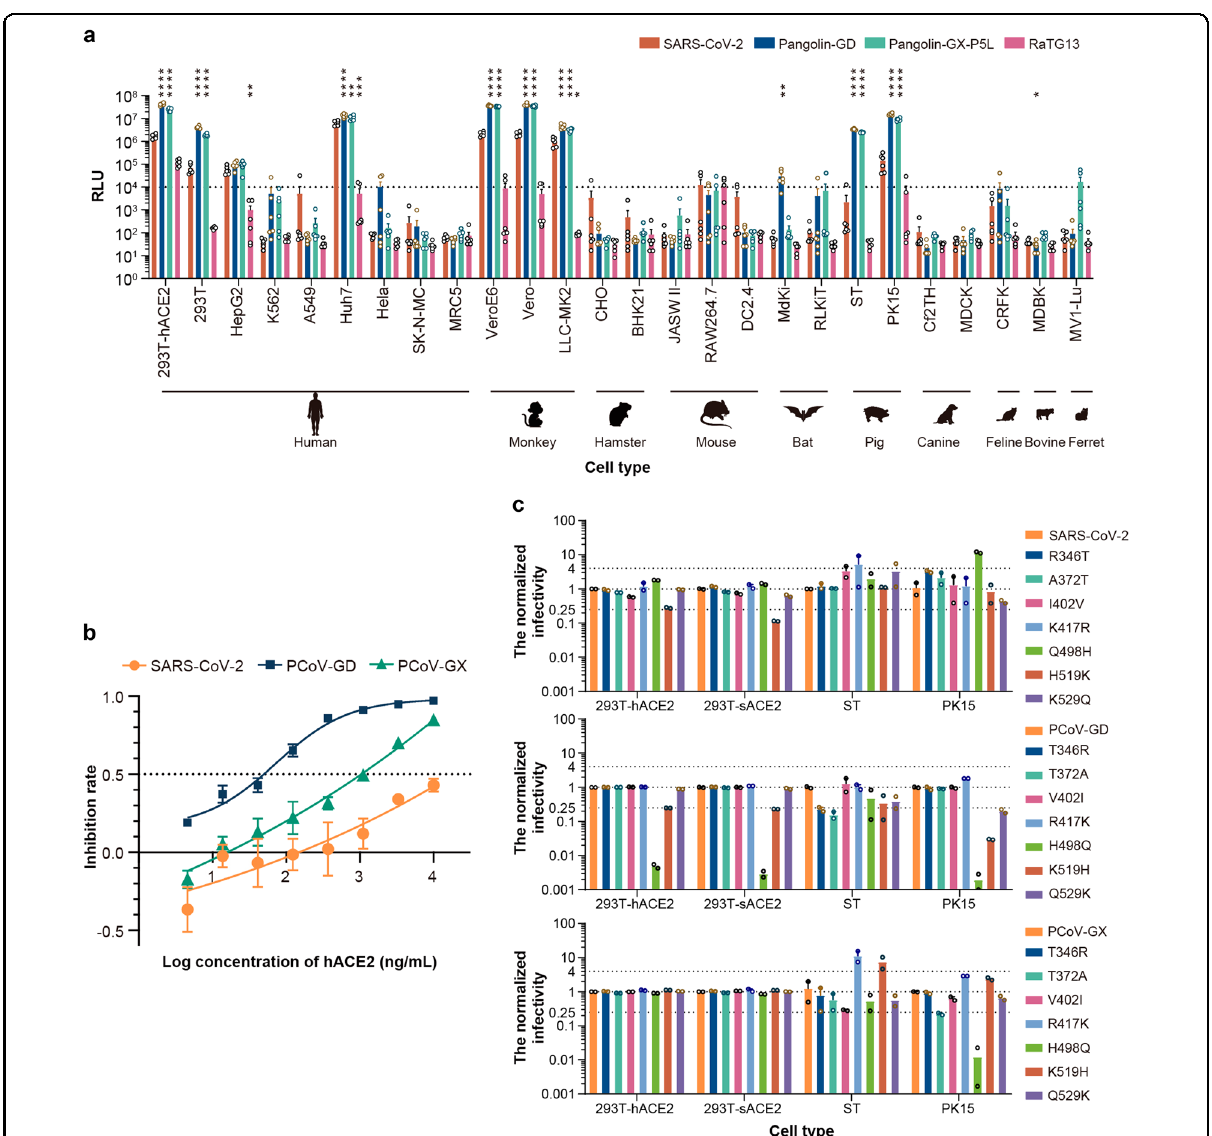
Fig. 1 Infectivity analyses of the coronaviruses. a SARS-CoV-2, PCoV-GD, PCoV-GX, and RaTG13 pseudotyped viruses were used to infect a total of 26 cell lines. The infected cell lysates were analyzed for relative light units (RLU). All results were obtained from six independent experiments (mean ± SEM). In each experiment, the infection assay was performed in duplicate wells. The average value of the duplicate wells was presented in the plot as a circle. The one-way ANOVA and Dunnett ’ s multiple comparisons test were employed to study the differences of infectivity between SARS-CoV-2 and the other three coronaviruses. When the RLU for the tested cell reached 1% of that for 293T-hACE2 cell, it was deemed as a susceptible cell line. The dashed line indicates the 1% RLU value of the 293T-hACE2 cell. b The infections of SARS-CoV-2, PCoV-GD, PCoV-GX, and RaTG13 pseudotyped viruses to 293T-hACE2 could be inhibited by soluble hACE2. All results were obtained from six independent experiments (mean ± SEM). In each experiment, the infection assay was performed in duplicate wells. c The relative infectivity of the pseudotyped viruses with mutant S protein was presented as the ratio of RLU for mutants/RLU for original ones. All results were obtained from two independent experiments (mean ± SEM). In each experiment, the infection assay was performed in duplicate